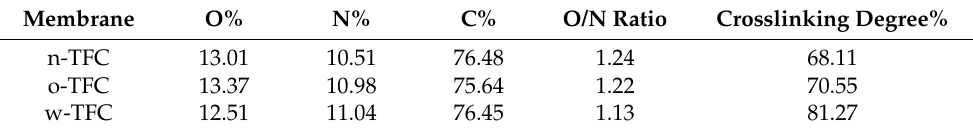
Table 3. Two curve-fitted peak components of high-resolution O 1s of nanofiber-supported PA Table 2. Atomic compositions of nanofiber-supported PA layers prepared via different heat-curing layers prepared via different heat-curing methods.